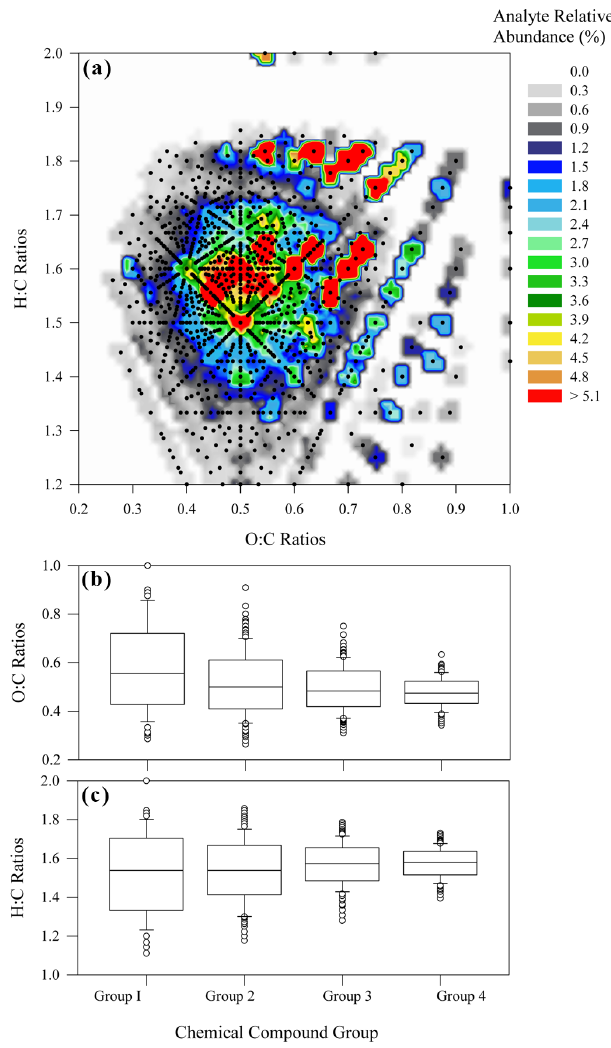
Fig. 5. (a) Depiction of the degree of oxidation for the common negative ions of the samples. Data points have been color coded according to the logarithm of their relative abundances in the mass spectrum. Boxplots (b, c) of O:C and H:C ratios are plotted with respect to the defined groups (Group I is 140 < m/z < 300, Group II is 300 < m/z < 500, Group III is 500 < m/z < 700 and Group IV is 700 < m/z <